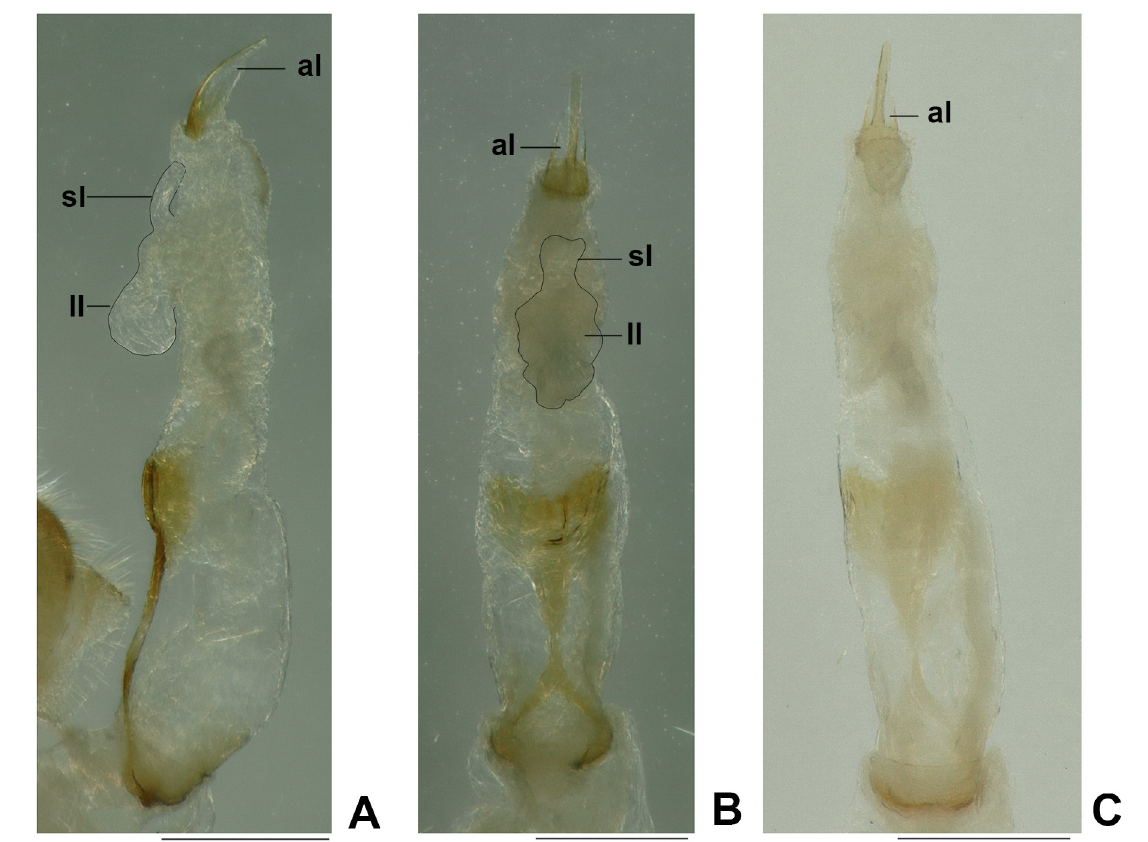
Fig. 12. Chinoperla gorohovi Sivec & Stark, 2010, ♂ (CAU). A . Aedeagus, lateral view. B . Aedeagus, dorsal view. C . Aedeagus, ventral view. Abbreviations: see Material and methods. Scale bars = 0.25